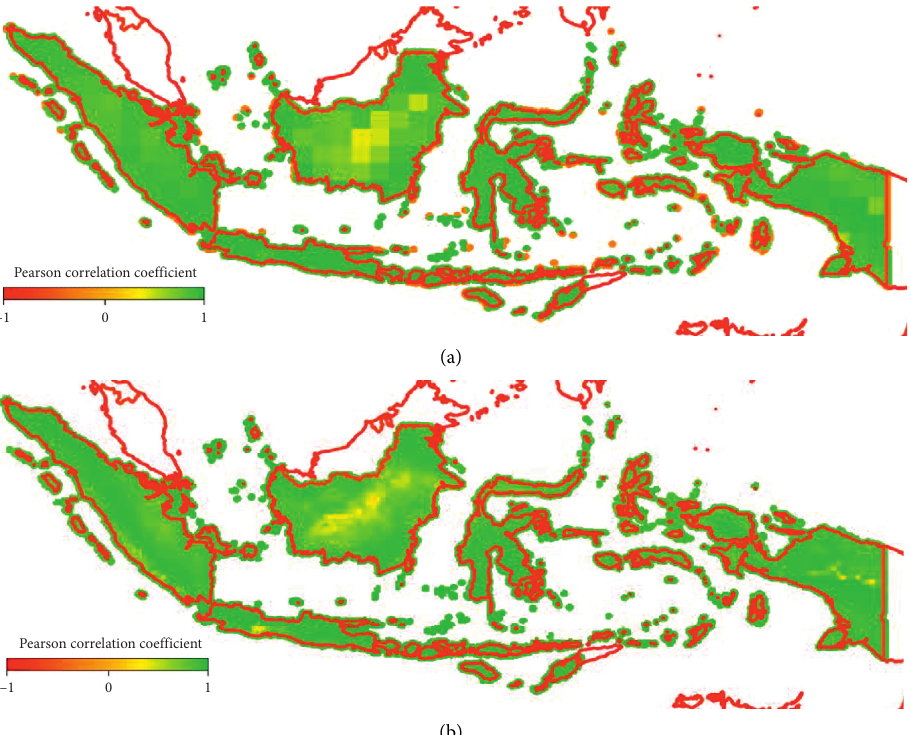
Figure 2: Representative figure of correlation coefficient between two databases. (a) POWER vs SolarGIS. (b) CLARA-A2 vs